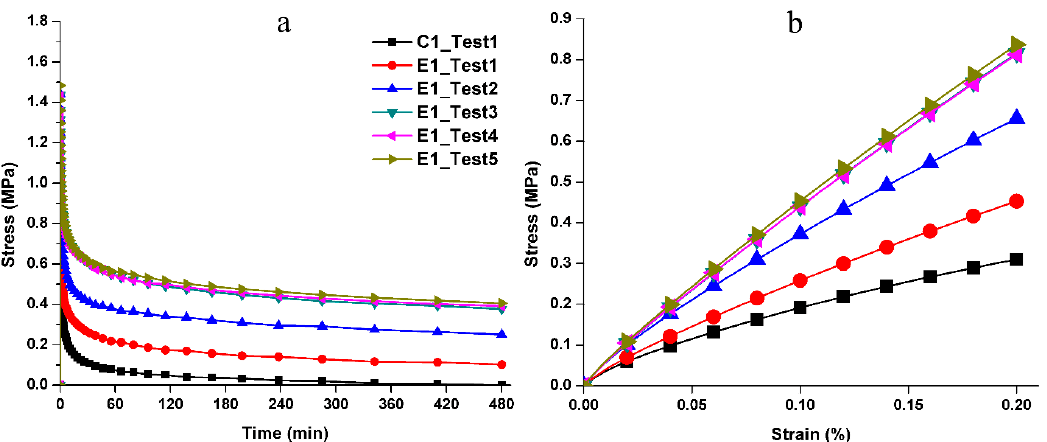
Figure 5. ( a ) Stress-time relationship from stress relaxation study and ( b ) stress-strain relationship Figure 5 . ( a ) Stress ‒ time relationship from stress relaxation study and ( b ) stress ‒ strain predicted using Prony-series-fitted relationship predicted using Prony-series-fitted parameters.